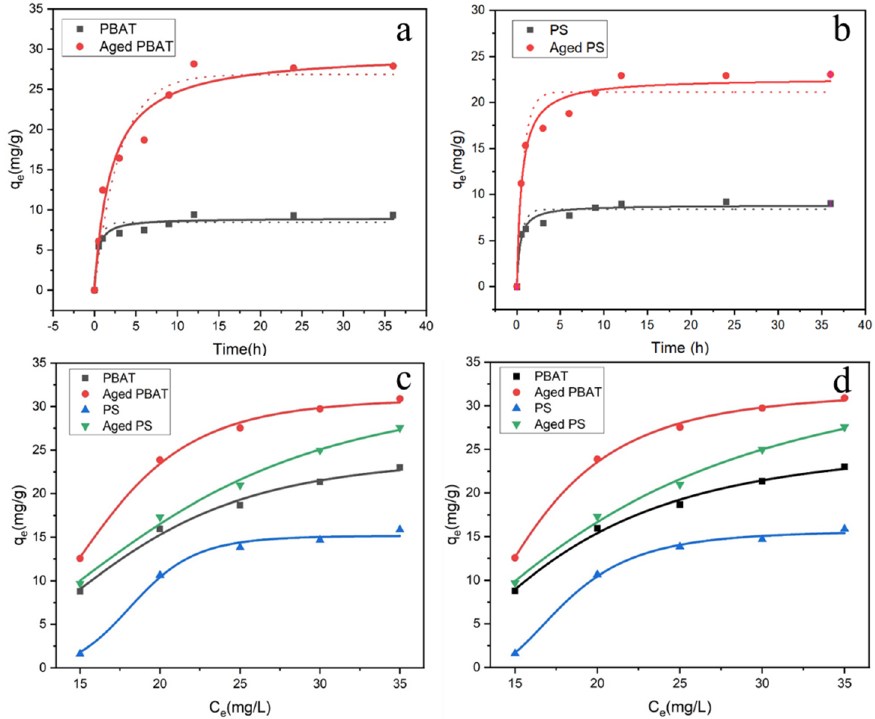
Figure 7. Adsorption kinetics of DCF by MPs (( a ) PBAT, ( b ) PS), and the adsorption isotherms (( c ) Langmuir model, ( d ) Freundlich model).